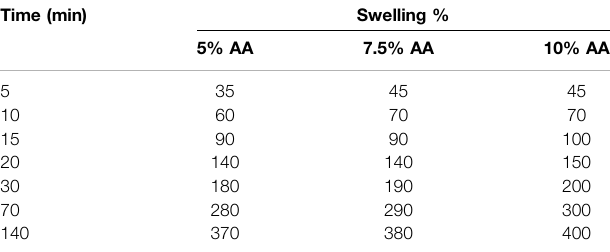
TABLE 1 | Swelling behavior of chitosan fi lms.